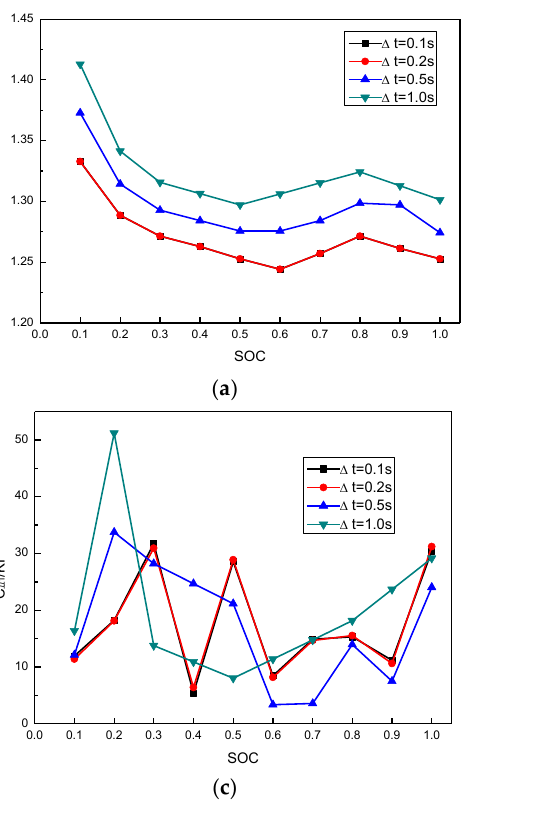
Figure 11. Change curves of parameters with SOC of 1-RC circuit model: ( a ) R I0 ; ( b ) R I ; ( c ) C I ; ( d ) τ I .